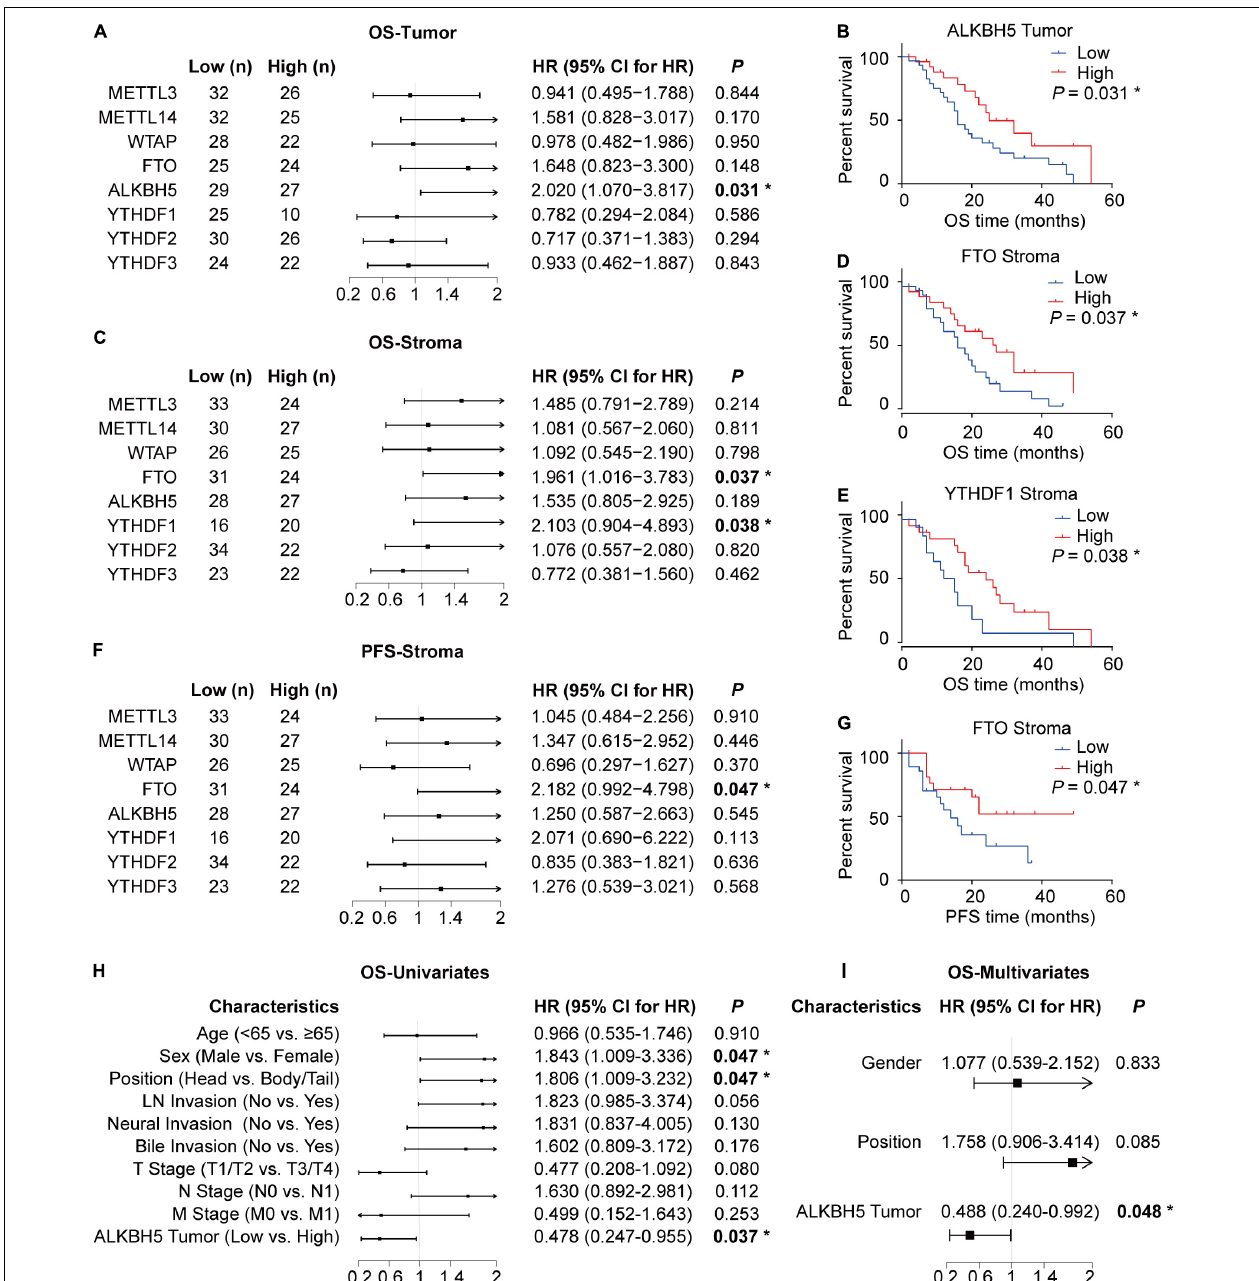
FIGURE 2 | Downregulation of ALKBH5 in PDAC predicts poor prognosis. (A) Log-rank analysis of correlation between overall survival (OS) and the expression of each m 6 A regulator in tumor. (B,C) Log-rank analysis of correlation between OS or progression-free survival (PFS) and the expression of m 6 A regulators in stroma. (D–G) Kaplan–Meier analysis of correlation between OS or PFS and ALKBH5, FTO, and YTHDF1 protein expression. (H,I) Cox regression analysis for OS in PDAC patients. * P <